Question: Does the plotted quantity increase or decrease?
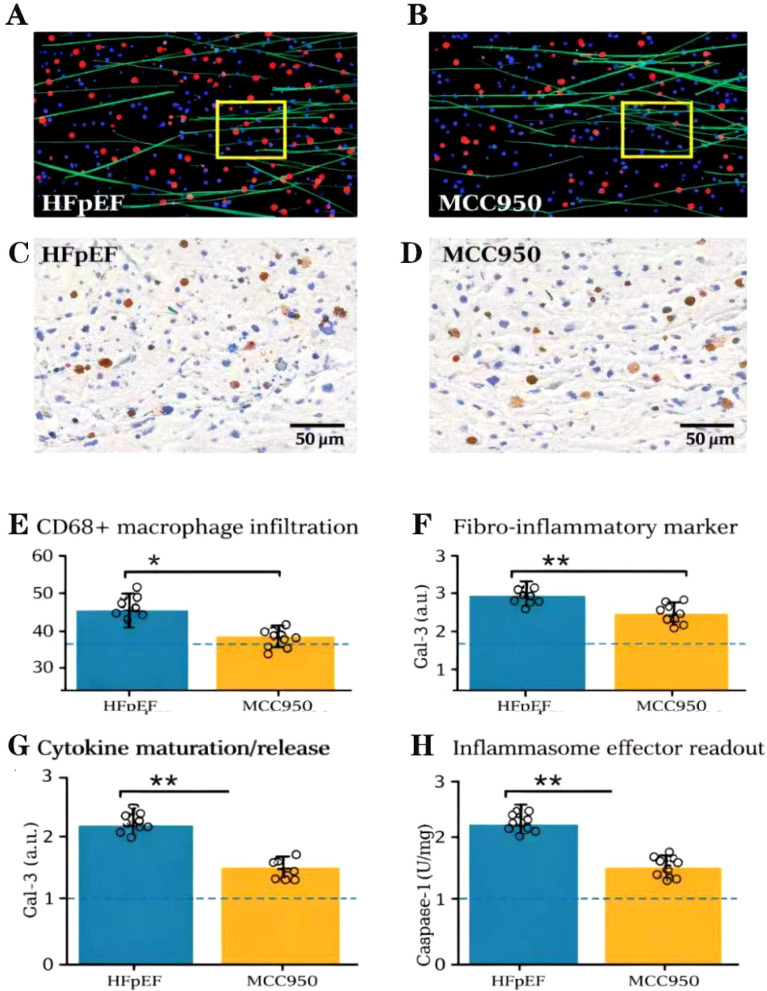
Answer: decreasing